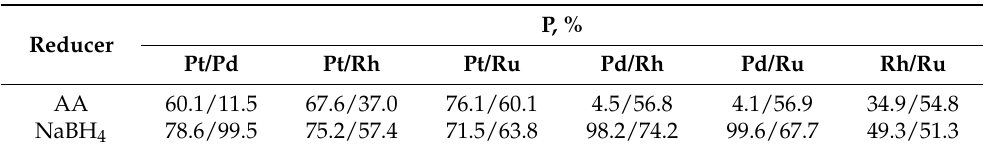
Table 3. Precipitation yield of Pt, Pd, Rh and Ru from two-component mixture using one of two selected reducers: AA and NaBH 4 .